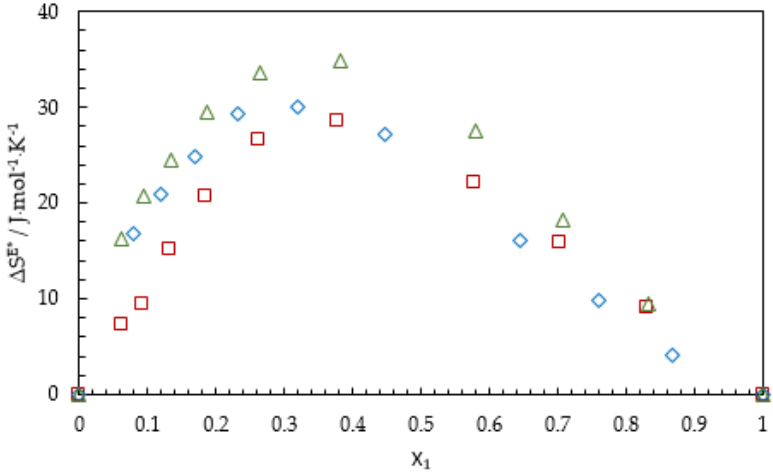
Figure 5. Excess entropy of activation for viscous flow ( ∆ S E * ) for MDEA (1) + H 2 O (2), ‘ □ ’; DMEA (1) + H 2 O (2), ‘ ◊ ’ and DEEA (1) + H 2 O (2), ‘ ∆ ’ mixtures as a function of mole fractions.